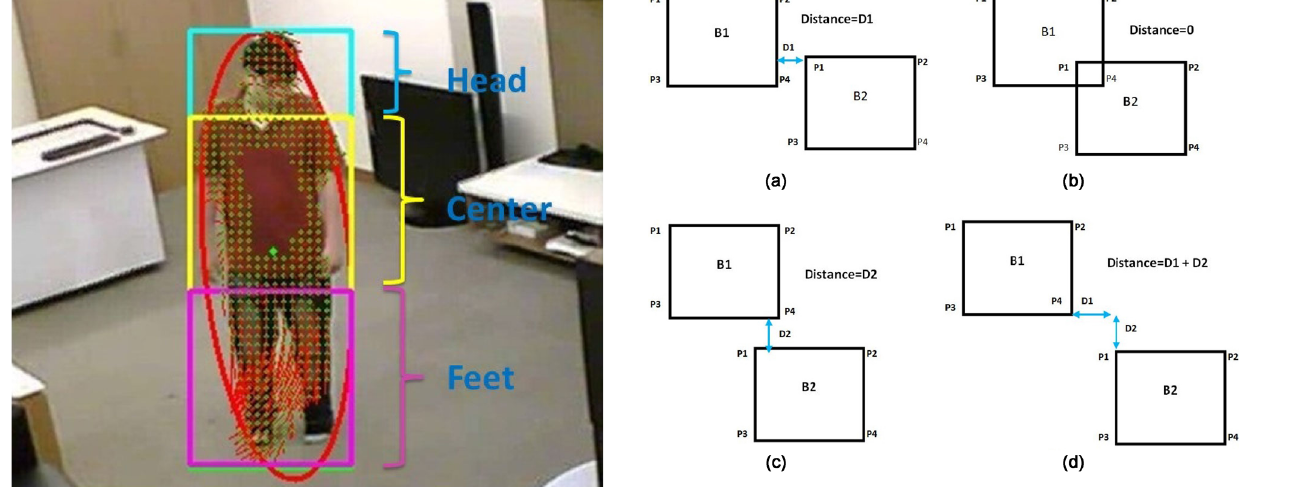
Fig. 3 Four examples of distances between two blobs.